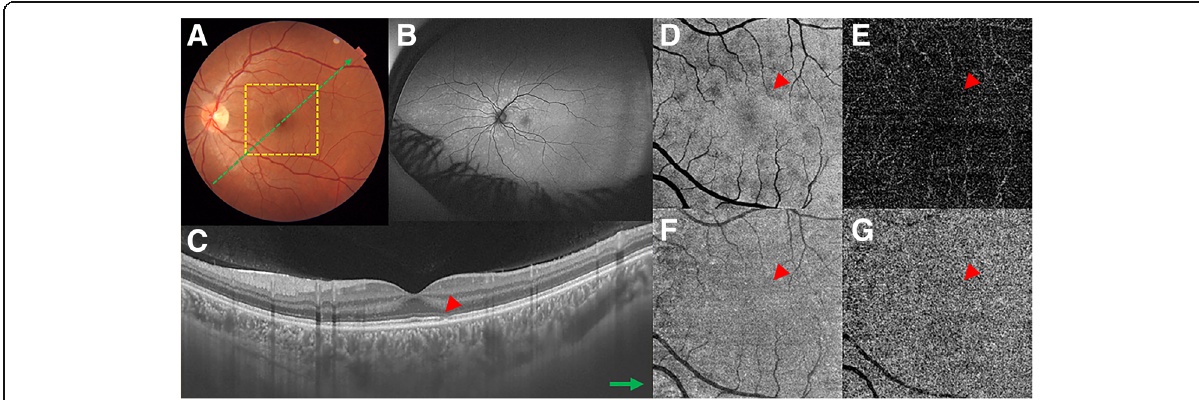
Fig. 1 Case #1. Multimodal imaging of a 28-year-old woman with multiple evanescent white dot syndrome (MEWDS). a Color fundus imaging shows discrete white lesions in the macular area. b Wide-field fundus autofluorecence (FAF) depicts a peripapillary hyperautofluorescent area associated with widespread hyperautofluorescent lesions in the retinal fundus. c Swept-source cross-sectional optical coherence tomography (OCT) represented by the green line in image a shows disruption of the ellipsoid zone (EZ) (red arrowhead). d En-face OCT at the level of the outer retina shows hyporeflective spots that corresponded to the EZ disruption on cross-sectional OCT (red arrowhead). e – g OCT angiography (OCTA) of outer retina ( e ), en-face OCT at the level of choriocapillaris ( f ), and OCTA of choriocapillaris ( g ) show homogeneous reflectivity without artifacts or any other